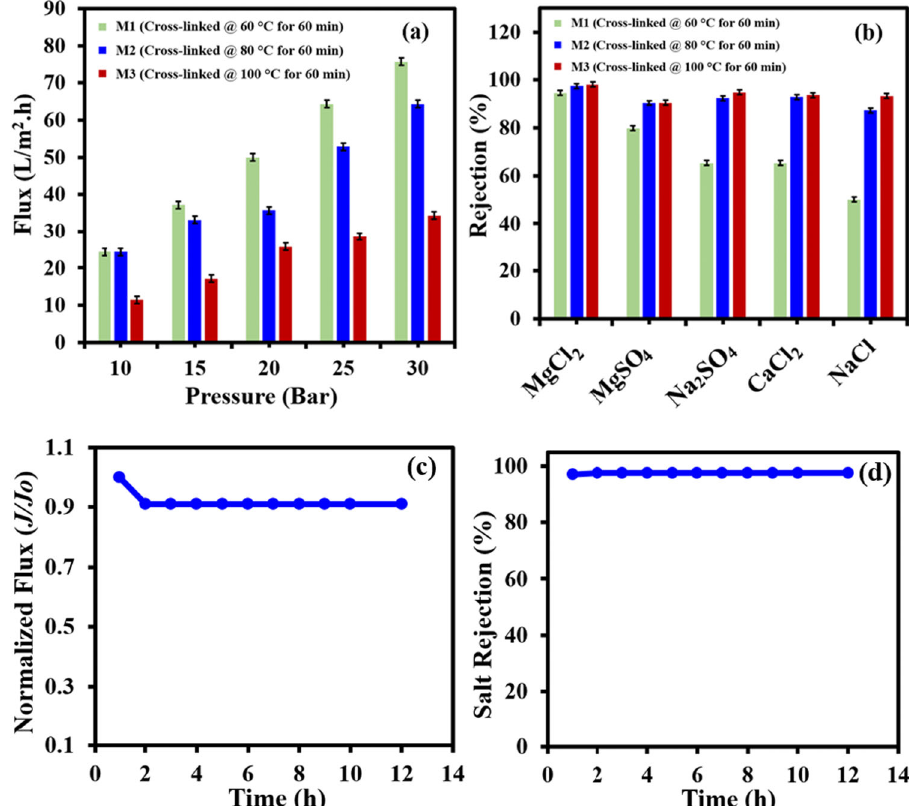
Fig. 7 Study of transmembrane pressure variation and salt rejection. a Effect of different pressure on water fl ux of the membranes, fabricated at different cross-linking temperature (Temperature: 60, 80, and 100 °C; Time: 60 min) using cross- fl ow nano fi ltration setup, b Salt rejection performance of the membranes, fabricated at different cross-linking temperatures 60, 80, and 100 °C; Cross-linking Time: 60 min) using cross- fl ow fi ltration setup at constant pressure (20 bar) and c , d long-term stability test for performance evaluation of